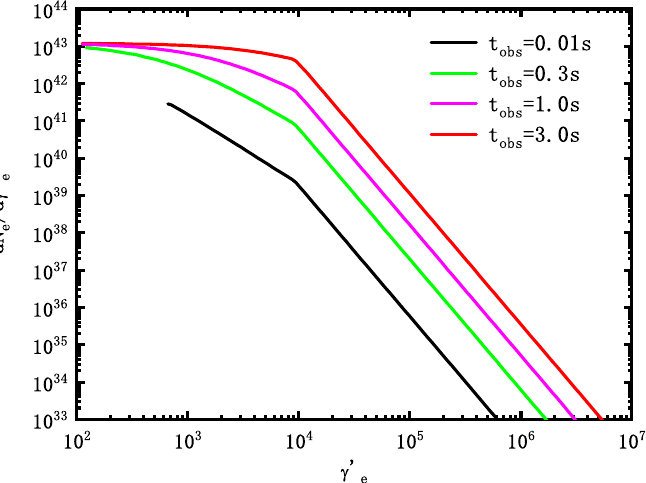
Figure 2. The electron distribution in energy space after cooling time t in the evolutional magnetic field in Figure 1. The same δ t , t crs , and dynamics parameters as in Figure 1 are taken in numerical